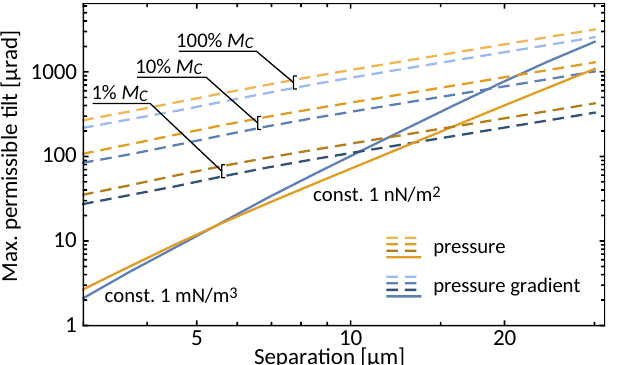
Figure 2. Maximum permissible tilt angle between the plates for an error of δ P = 1nN/m 2 for pressures and δ P (cid:48) = 1mN/m 3 for pressure gradients (solid lines). The dashed lines indicate the angle at which the error δ M in the measured pressure or pressure gradient corresponds to the indicated fraction of the Casimir pressure or Casimir pressure gradient,